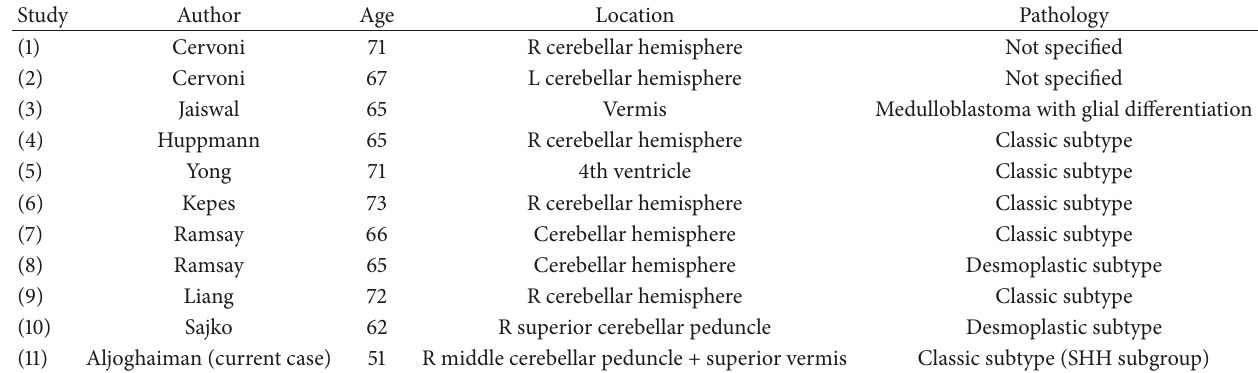
Table 1: Cases of Medulloblastoma in patients above the age of